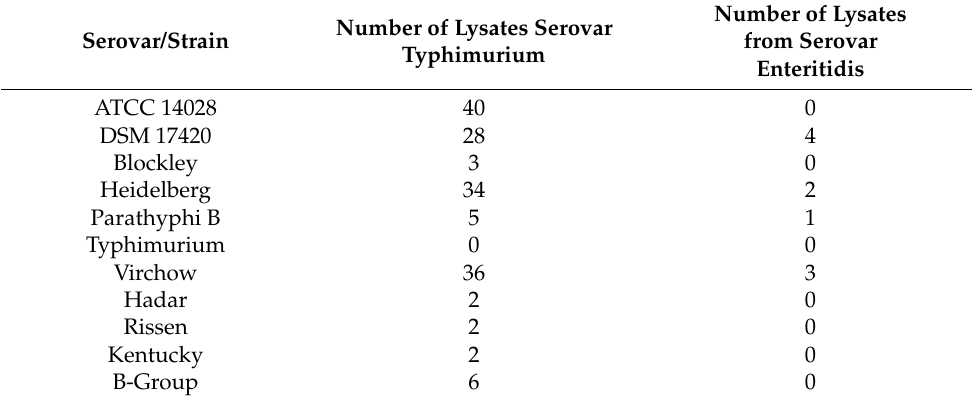
Table 2. Lysis of different S . serovars by the propagated prophage lysates. Number of Lysates Serovar/Strain